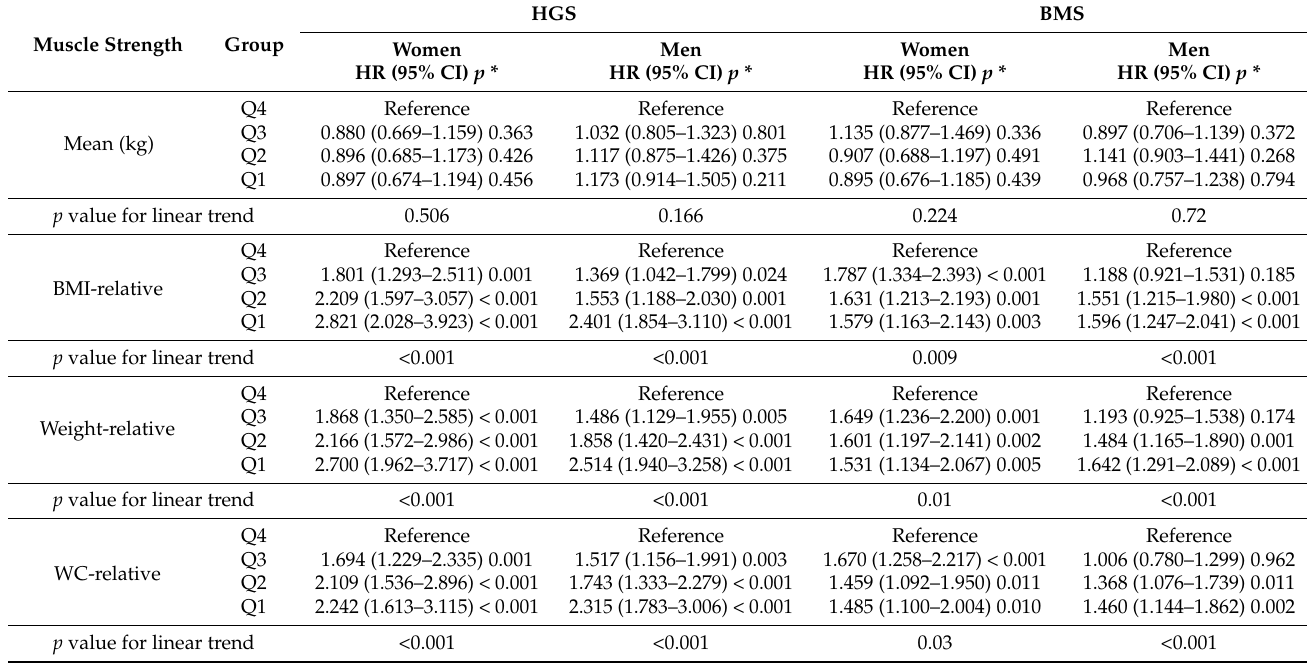
Table 3. Adjusted hazard ratio (HR) of incident metabolic syndrome associated with quartile group of mean hand grip strength, back muscle strength, and relative muscle strength according to